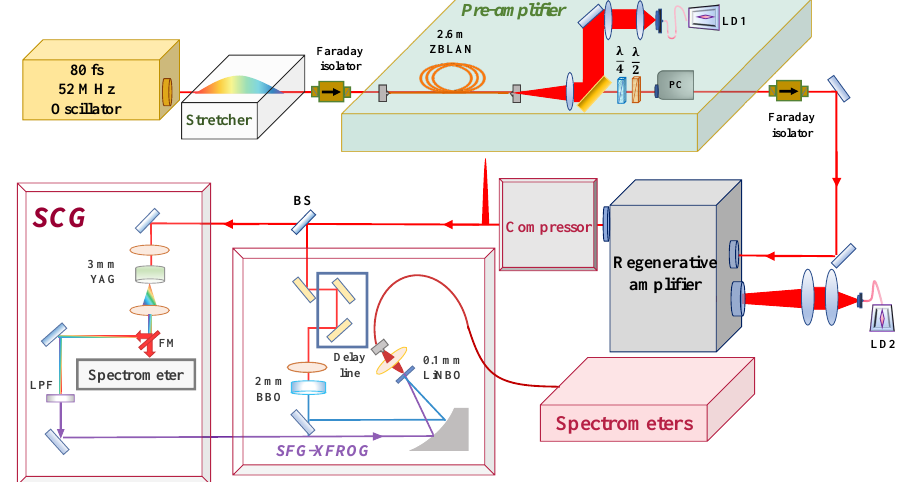
Figure 1. Schematic design of the experimental setup. LD, laser diode. BS, beam splitter. FM, folding mirror. PC, Pockels cell. SCG, supercontinuum generation. SFG-XFROG, sum-frequency generation cross-correlation frequency-resolved optical gating.